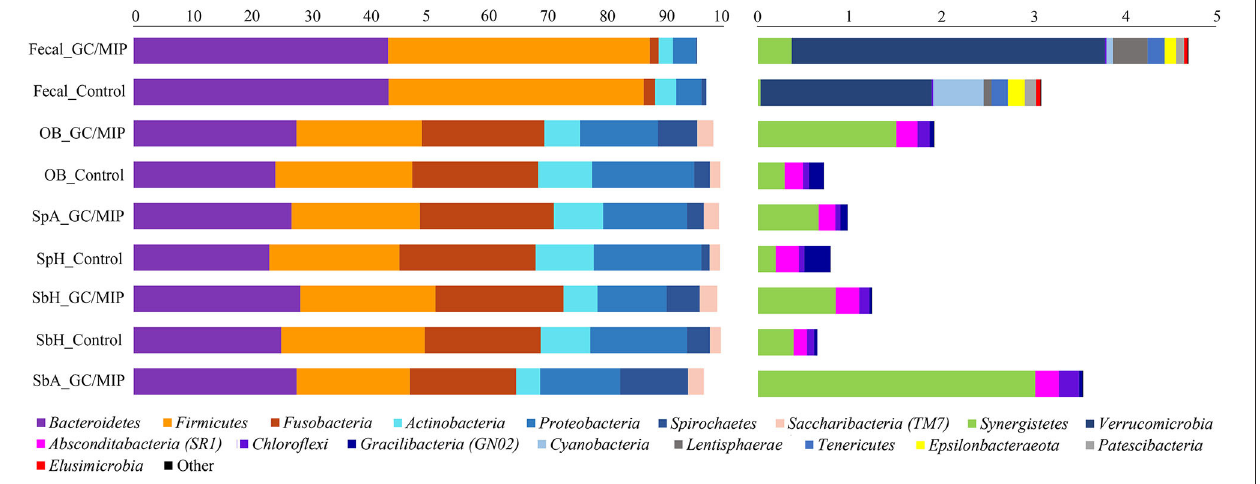
FIGURE 1 | Phyla relative abundance (%) based plots. The left plot represents the most abundant phyla ( > 1%) and the right plot represents the least abundant phyla ( < 1%) detected in GC/MIP and Control samples: fecal samples (Fecal_GC/MIP and Fecal_Control), oral biofilm samples (OB_GC/MIP and OB_Control, where OB refers to the sum of reads of each taxon detected in all biofilm samples per group: SpA + SbH + SbA in GC/MIP and SpH + SbH in Control groups), supragingival biofilms (SpA_GC/MIP and SpH_Control), subgingival healthy sites (SbH_GC/MIP and SbH_Control), and subgingival affected sites